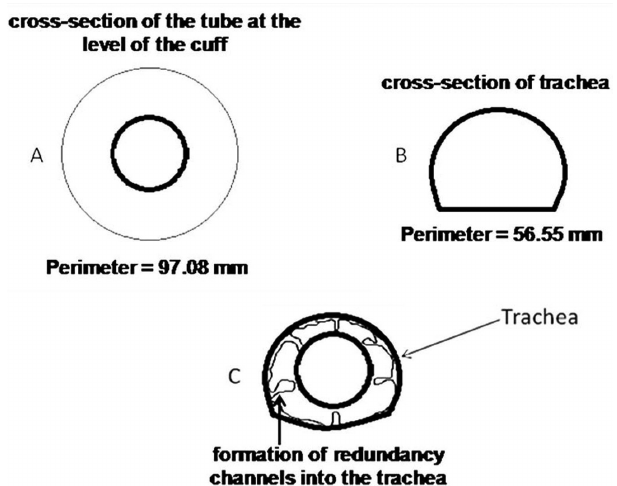
Fig.1 - Cross-sectional area of the tube (A) demonstrates its outer ring and inner cuff. Item B corresponds to the format of the trachea and its perimeter. (C) Cross-sectional area of the endotracheal tube adapted to the tracheal lumen with redundancy channels formed, which can allow the passage of